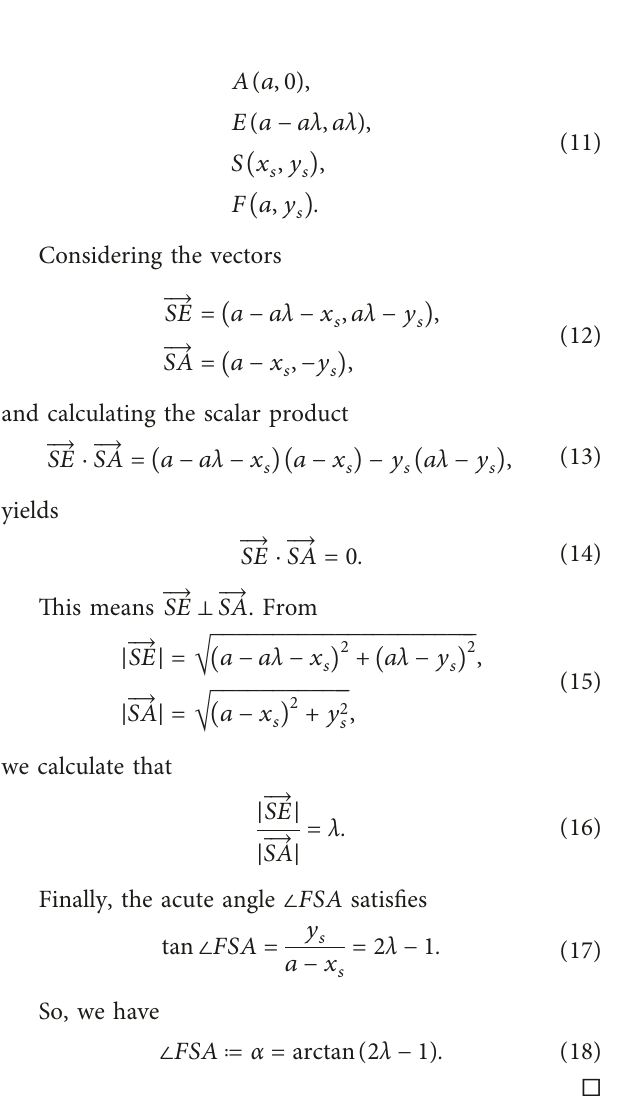
Figure 3: The schematic diagram for Property